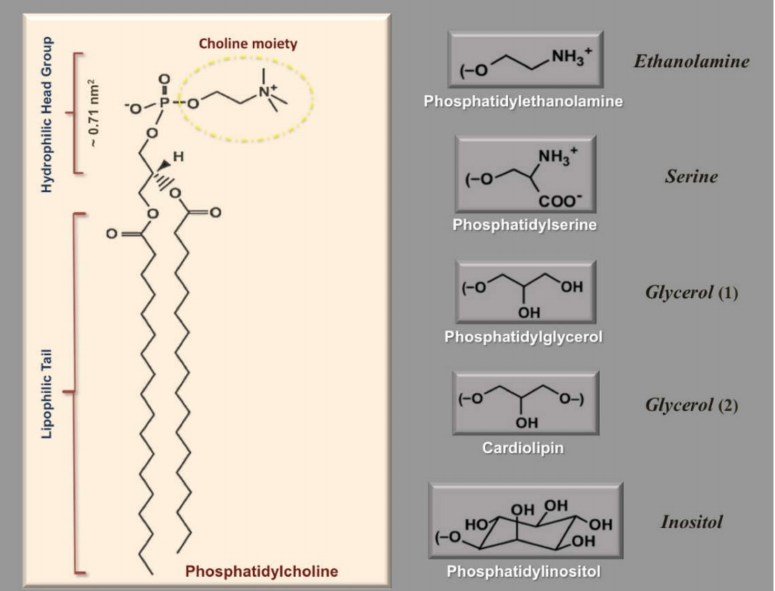
Figure 1. Structural formula of phosphatidylcholine molecule and its derivatives/related phospho- lipids. The chemical moieties on the right panel replace the Choline moiety depicted on the left panel, and hence each phospholipid molecule is named based on its specific moiety on its hydrophilic head group.